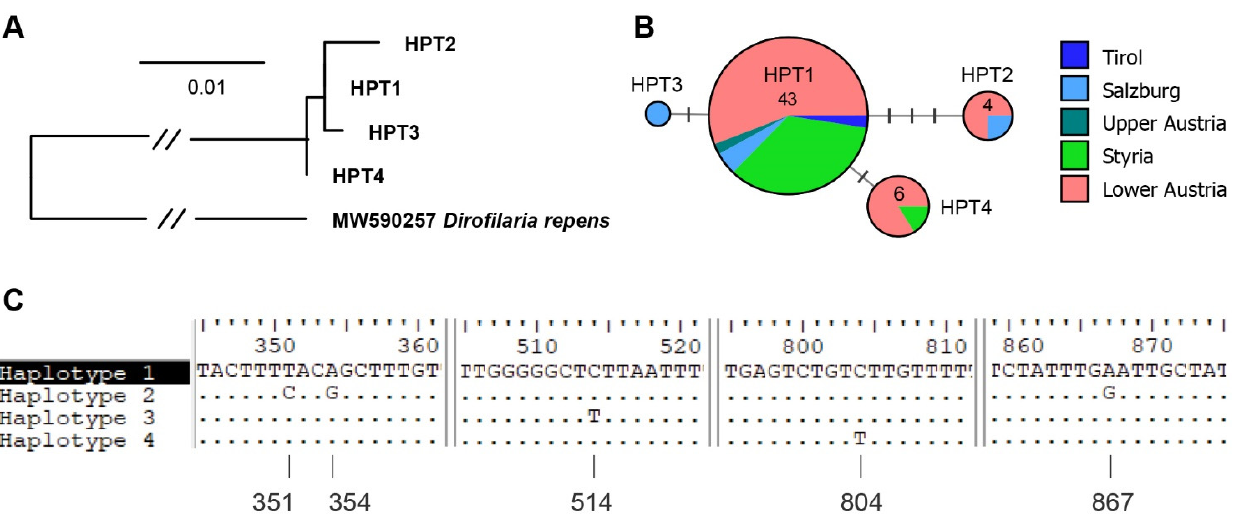
Figure 3. ( A ) Maximum likelihood tree of the four cytochrome c oxidase subunit I ( COI ) haplotypes (HPT1–4) with a Dirofilaria repens sequence from GenBank (accession number: MW590257) as the outgroup; ( B ) median-joining haplotype network showing the distribution of different haplotypes per federal state and the number of individuals; ( C ) sequence alignment showing the nucleotide positions (counting from the 5 ′ -end of the COI ) differing between the four COI haplo- types.